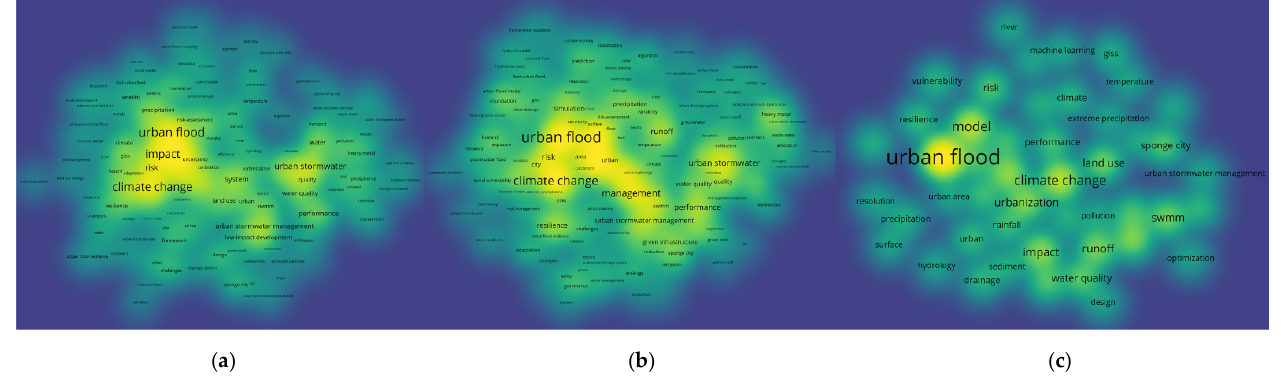
Figure 13. The density maps of the last three year’s keywords: ( a ) 2019; ( b ) 2020; ( c ) 2021.